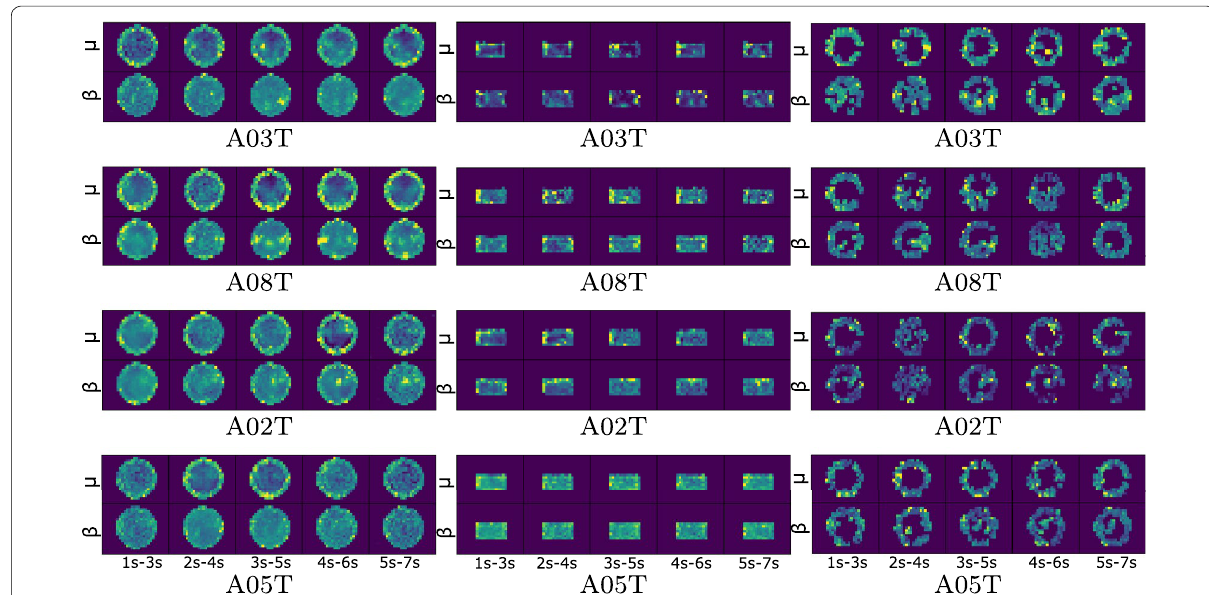
Fig. 5 Relevance weights computed for representative individuals (best‑performing A03T and A08T and worst‑performing A02T and A05T) in terms of performed three‑class accuracy for scenario C : without spatial dropping (left column), spatial dropping by weighing only all sensorimotor electrodes (middle column), spatial dropping by excluding nonrelevant electrodes (right